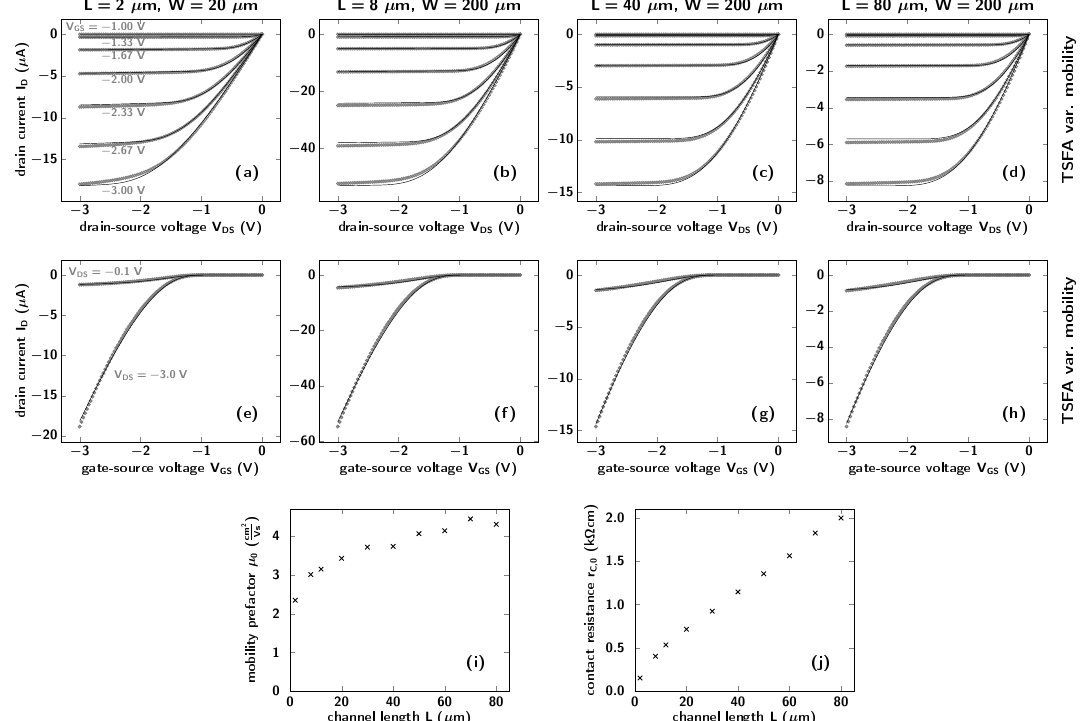
Figure 5. Results of the TSFA for the model with a field- and charge-carrier-density-dependent mobility. In ( a – h ), the measured output and transfer characteristics (gray symbols) and the calculated output and transfer characteristics (black lines) of bottom-gate, bottom-contact DNTT TFTs with channel lengths L of 2, 8, 40, and 80 µ m and channel widths W of 20 or 200 µ m are shown, indicating good agreement. Note that the gray symbols appear as an apparent thick line due to the close spacing of the data points. In ( i , j ), the channel-length dependence of the mobility prefactor µ 0 and the combined contact resistance r C ,0 = r S ,0 + r D ,0 indicates a failure of the